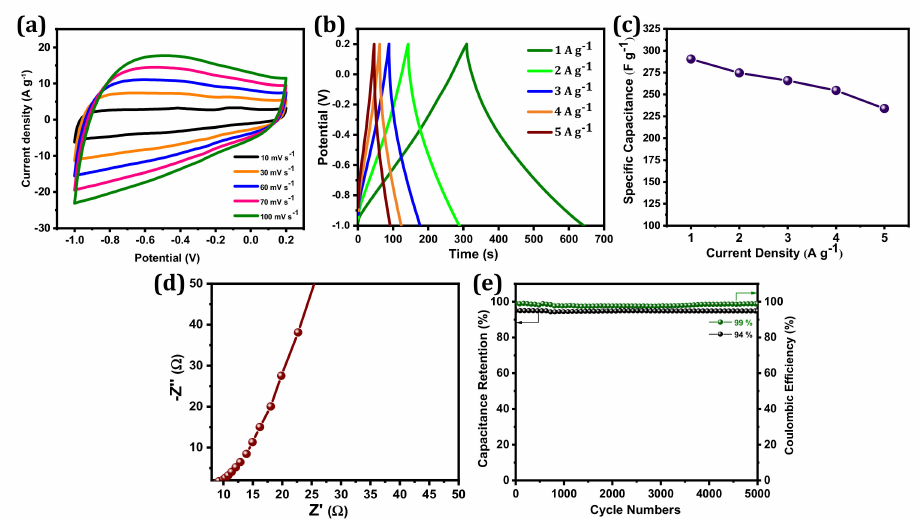
Figure 4. Electrochemical characterization of BSPC electrode: ( a ) CV curves at the scan rates of 10 to 100 mV s − 1 , ( b ) GCD curves at the specific current densities of 1 to 5 A g − 1 , ( c ) the specific capacitances at different specific currents ranging from 1 to 5 A g − 1 , ( d ) Nyquist plots with an amplitude of 10 mV s − 1 over a frequency range of 10 − 2 to 10 5 Hz, ( e ) cyclic stability and coulombic efficiency at a specific current of 5 A g − 1 over 5000 GCD